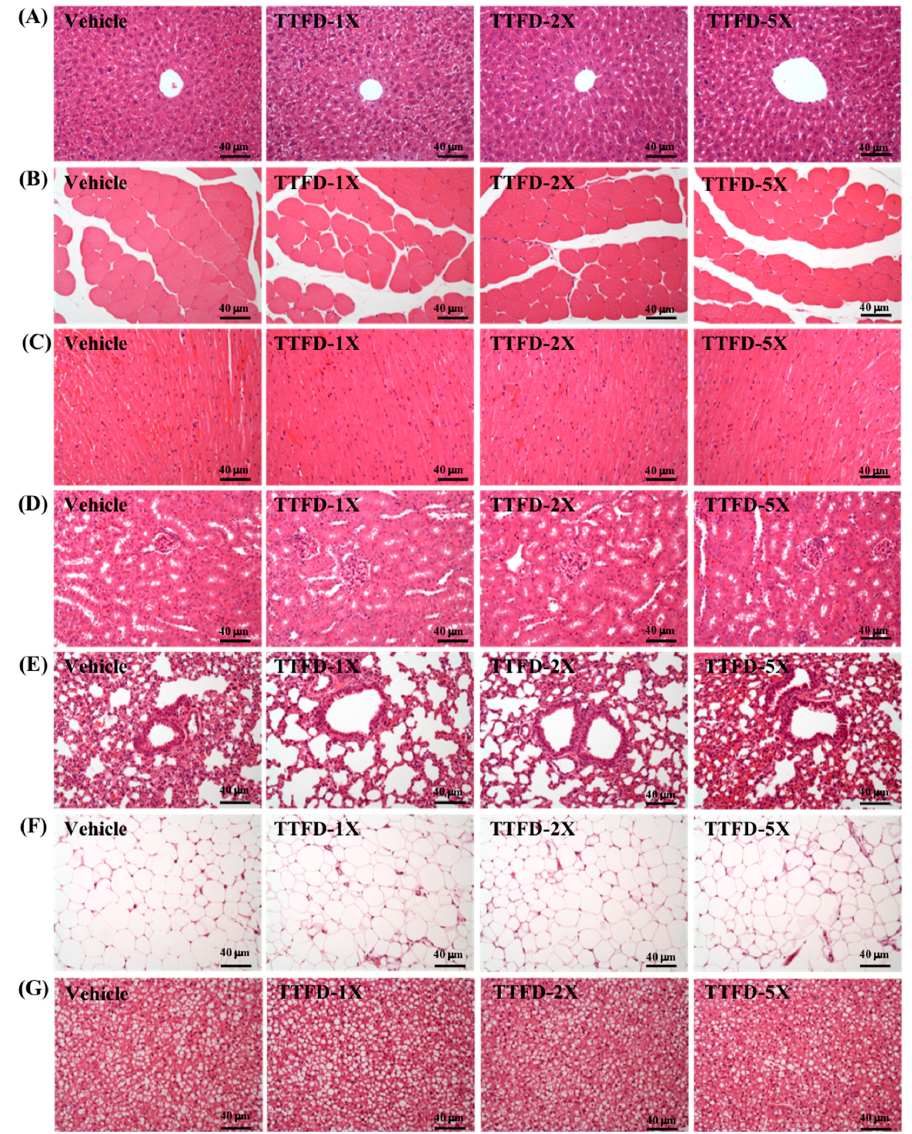
Figure 8. Effect of TTFD supplementation on histomorphologic features of the liver ( A ), muscle ( B ), heart ( C ), kidney ( D ), lung ( E ), white fat tissue ( F ) and BAT tissue ( G ) in mice. Specimens were photographed under a light microscope. (H&E stain, magnification: 200×; bar, 20 μ m).